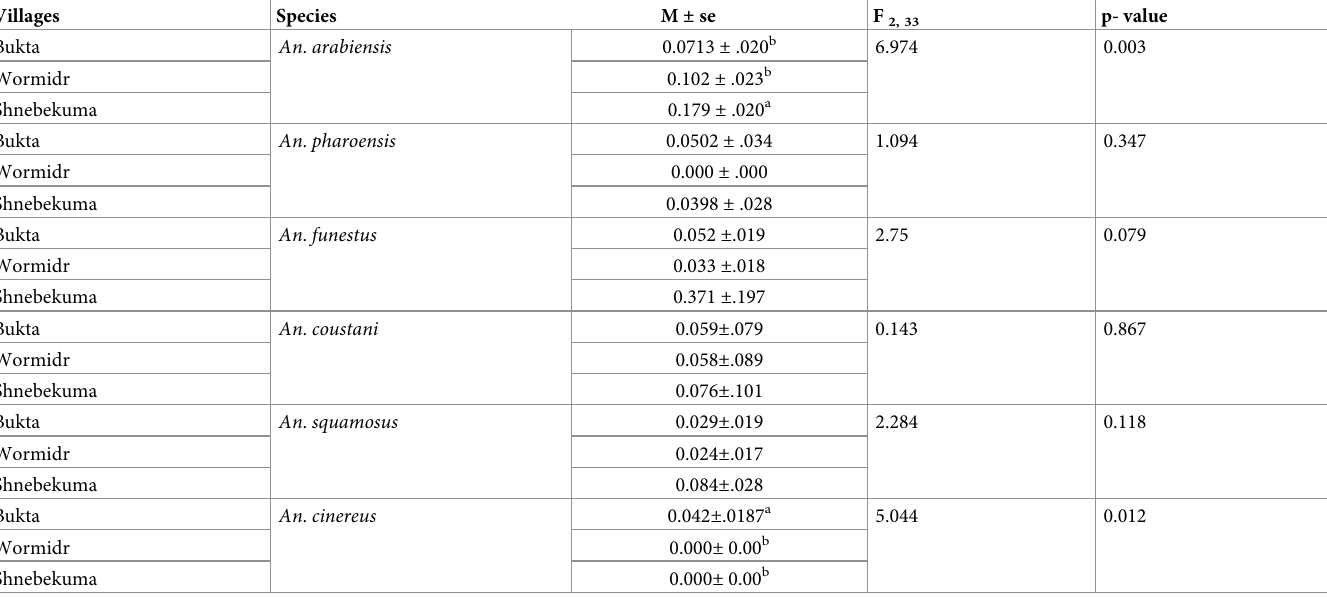
Table 3. Mean parous rate of Anopheles mosquito in the villages, Bure district, Ethiopia.